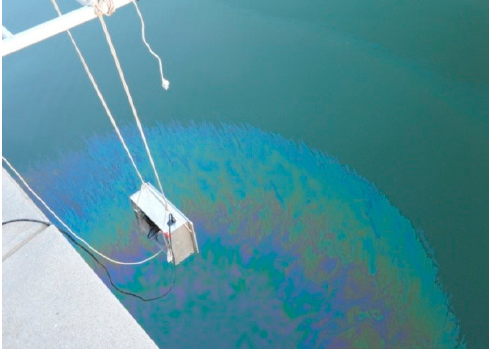
Figure 11. Observation site used for the continuous oil spill experiment.